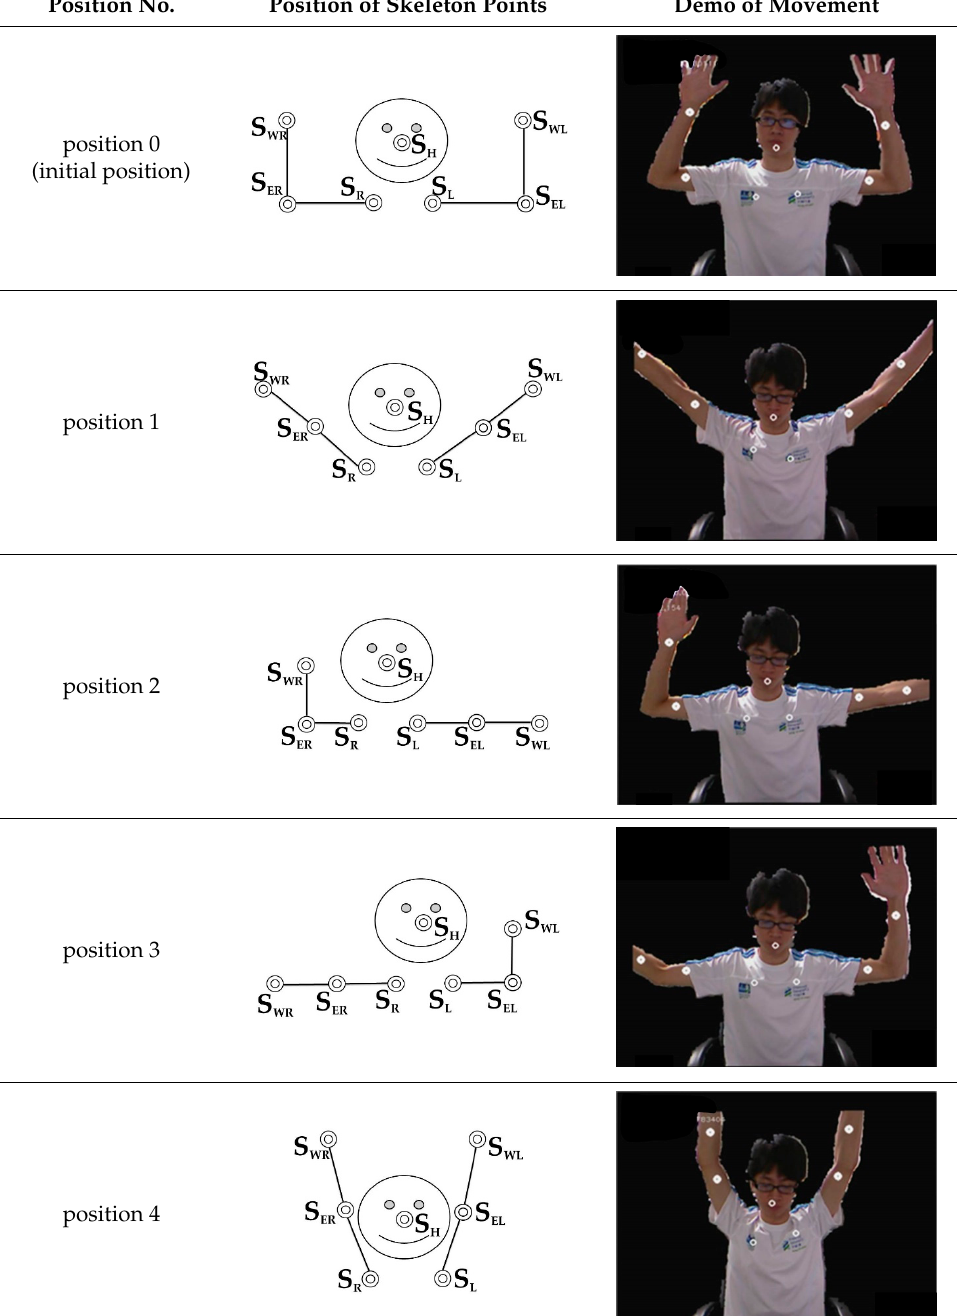
Table 1. Seven types of rehabilitation movement.